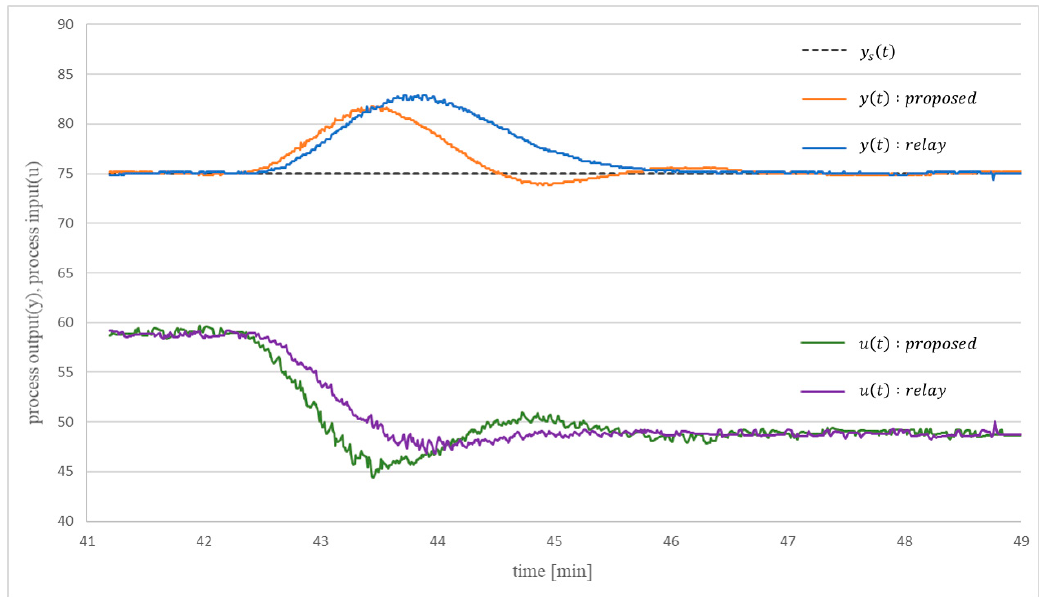
Figure 24. Control performance of the proportional–integral–derivative (PID) controllers tuned by the proposed autotuning method and the relay feedback method [1] at a step input disturbance condition. Table 9. Ultimate frequency response data and tuning parameters of the PID controller tuned by the proposed autotuning method.